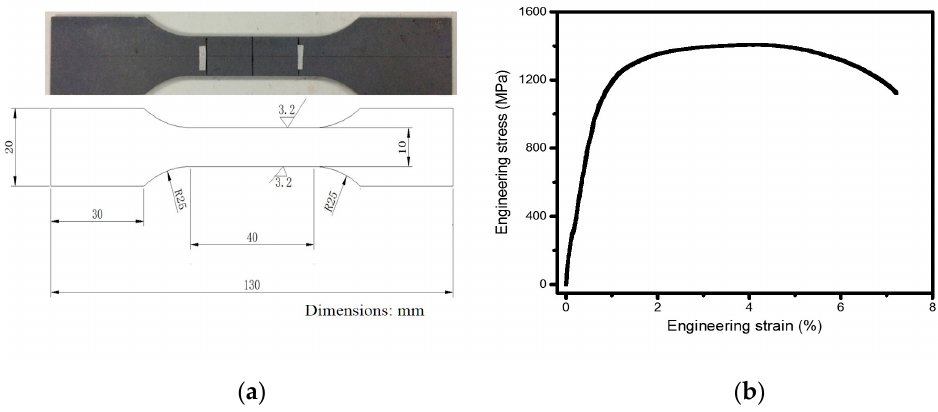
Figure 2. Experimental specimen and stress-strain curve of the B1500 steel: ( a ) Detailed geometrical specimen ( b ) Stress-strain curve.